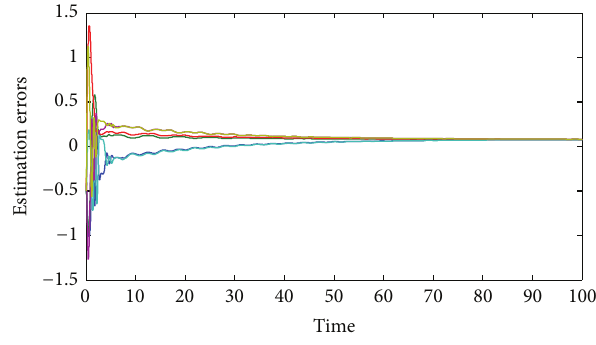
Figure 3: The trajectory of estimation